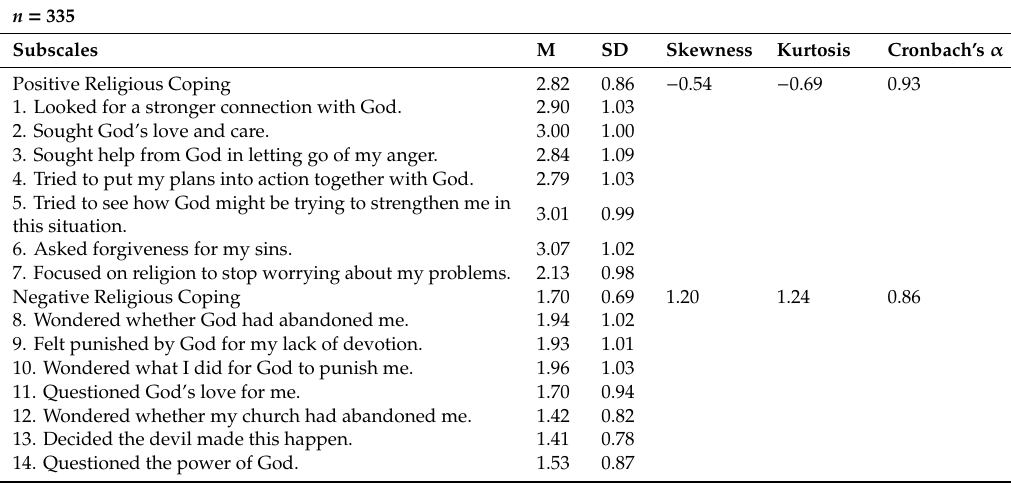
Table 2. Brief RCOPE Mean, Standard Deviation, Skewness, Kurtosis, and Cronbach’s α